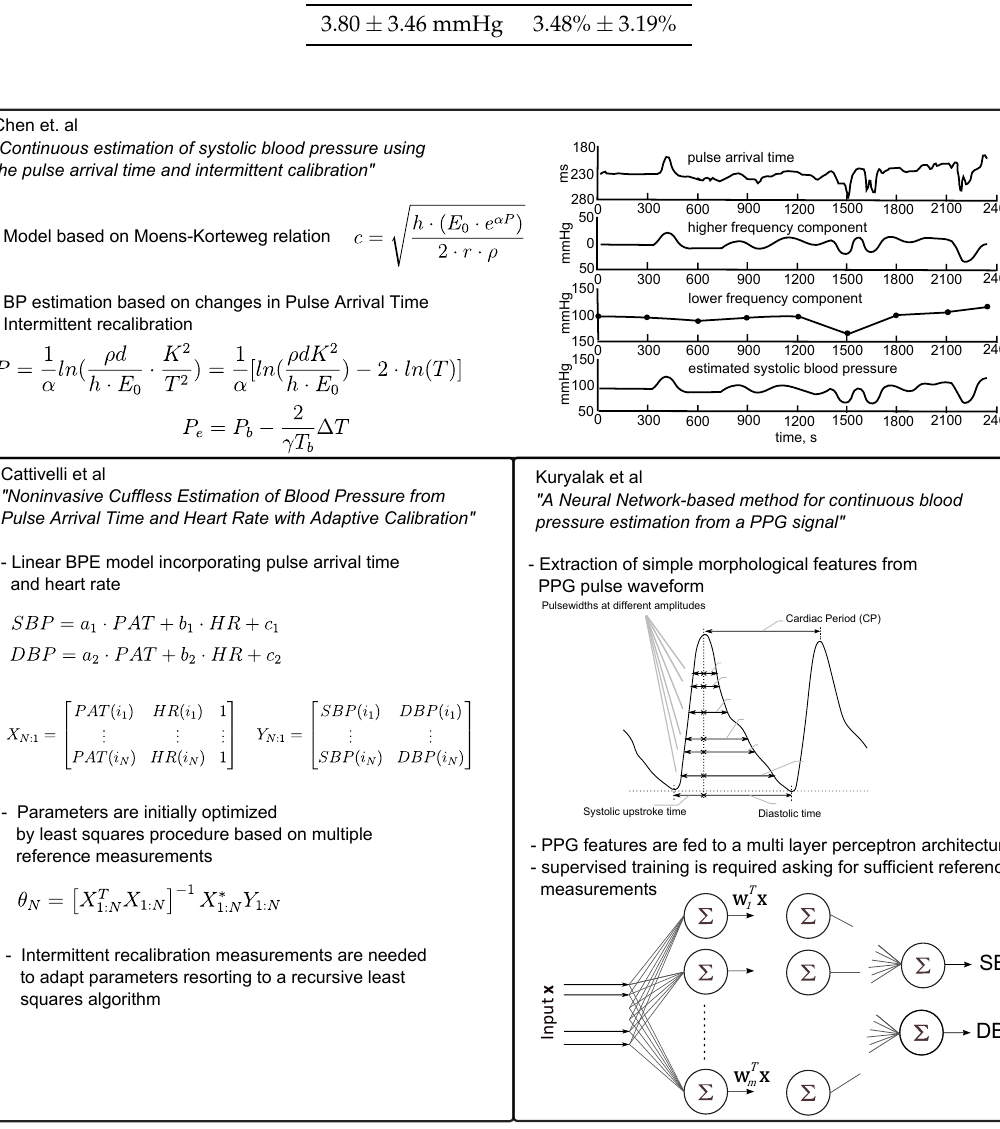
Figure 4. Overview on the implemented blood pressure estimation methods. Figures have been redrawn from the respective publications